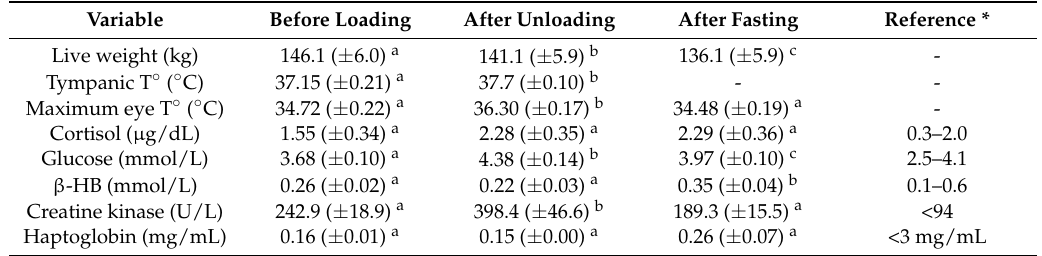
Table 2. Mean ( ± SE) of all the variables measured before loading, after unloading, and after the 24-h fasting